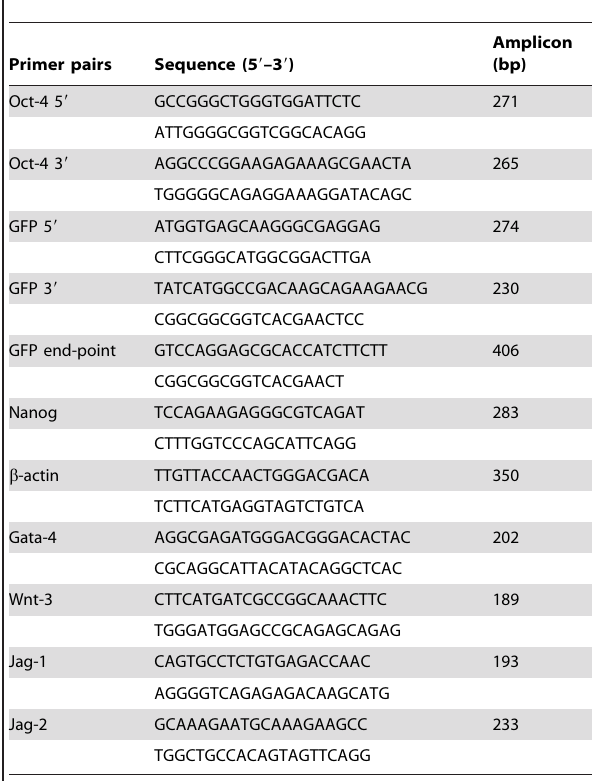
Table 1. Primers used for